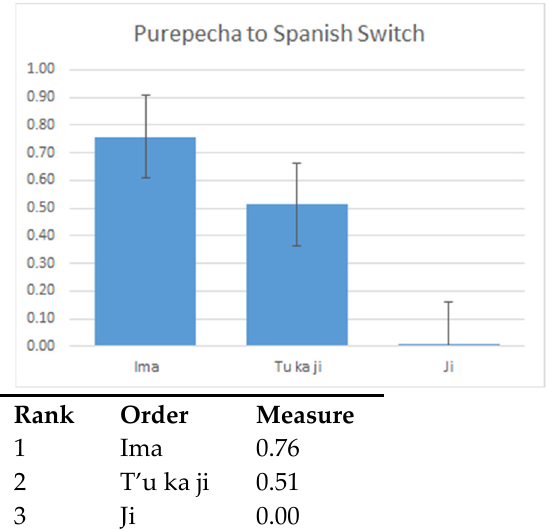
Figure 2. Rank ordering of 2AFC results for P’urhepecha to Spanish switches (above), including the measure of Thurstone’s analysis (below).